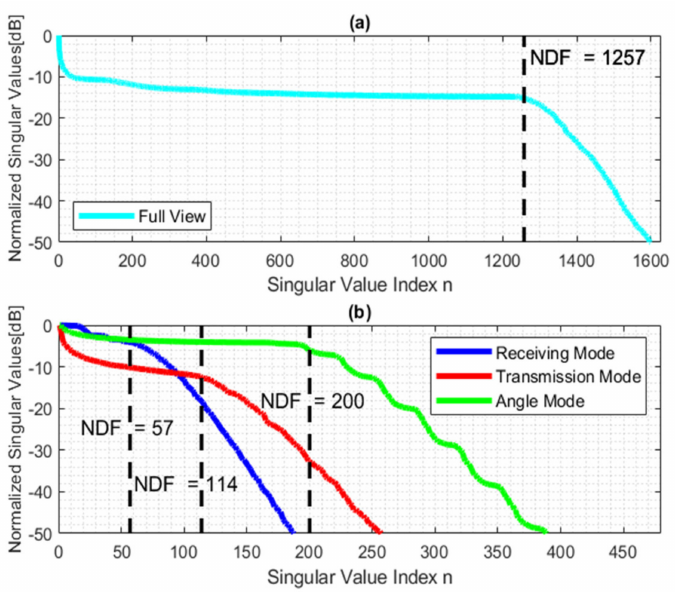
Figure 3. The behavior of the normalized singular values of the linearized inverse scattering: ( a ) full view, ( b ) three sensing modes. The dashed lack black line provides the analytically predicted